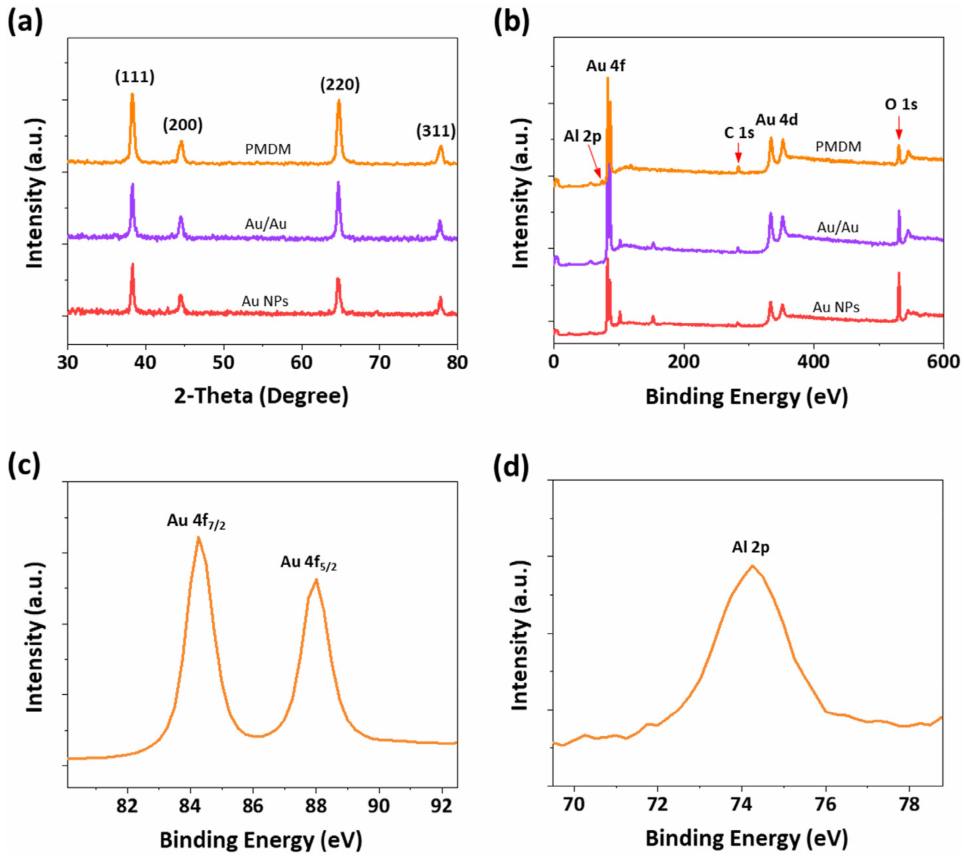
Figure 2. ( a ) XRD patterns of three different plasmonic nanostructures: Au, Au/Au, and PMDM hybrid nanostructures, as labeled. ( b ) XPS survey spectra of Au, Au/Au, and PMDM hybrid nanostructures. ( c , d ) High-resolution XPS spectra of Au 4f and Al 2p of PMDM hybrid